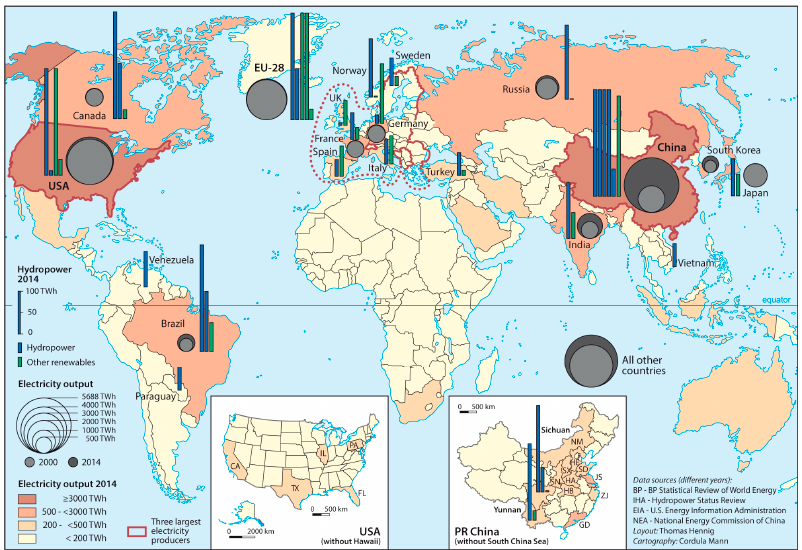
Figure 1. Yunnan in the global setting. Global electricity production (by nation, and in comparison to Chinese provinces and US states) and global hydropower production and production of other renewables (both in 2014) of the world’s largest hydroelectricity producers (only production ≥ 50 TWh). If the three largest producers (China, the United States and EU ‐ 28) are not seen as monolithic blocks, but rather considered as smaller entities (provinces, federal states or countries), huge regional disparities appear. For instance, some Chinese provinces (e.g., Jiangsu, Guangdong, Shandong) show an electricity demand comparable to that of France, Germany, Canada and Brazil—countries that are all among the ten largest electricity producers and consumers worldwide. Other Chinese provinces have a lower demand, but are large producers and therefore electricity exporters [3]. In that setting, especially provinces from China’s southwest emerge as major producers and exporters of hydroelectricity. This region has the world’s largest hydropower (HP) potential under development, concentrated especially in Sichuan Province, Yunnan Province, and the Tibet Autonomous Region (TAR), each of which currently has about 100 GW HP under development. HP development is already advanced in Sichuan (64.5 GW) and Yunnan (51.3 GW) while the exploitation of Tibet’s gigantic HP resources is just in the early stages [4]. As a comparison, the currently (2014) installed capacity in each of the two provinces is larger than in most other powerful HP nations such as India, Russia, Norway, and Switzerland. However, the major differences between the Yunnan and Sichuan cases are the drainage basins and related geopolitical implications. While Sichuan is almost exclusively drained by the domestic Yangtze basin (with a smaller region also by the domestic Yellow River basin), Yunnan shares a long international border with three other countries. Beside the Yangtze basin, it is therefore additionally drained by five transnational basins (Lancang ‐ Mekong, Nu ‐ Salween, Yuan ‐ Red River, Dulong ‐ Ayeyarwaddy [5] and Nanpan/Beipan ‐ headwaters of Pearl River). Yunnan is, for all its six basins, an upstream province and large upstream hydropower investments generally have pronounced downstream effects. Some scholars have argued that the level of vulnerability is fairly low for the upstream sections that lie within Yunnan, while the downstream influence is more substantial [6]. Others [7] further argue that upstream–downstream